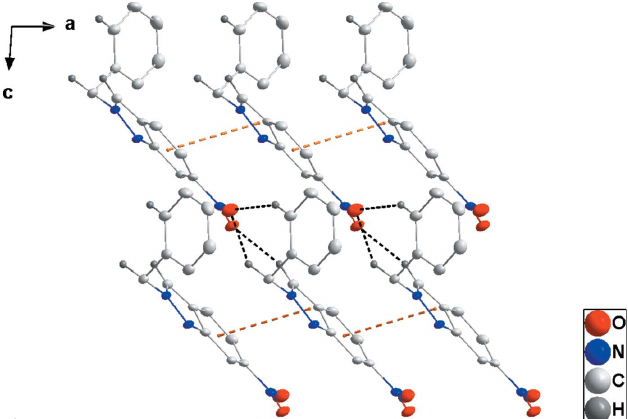
Figure 2 Detail of the intermolecular interactions, viewed along the b -axis direction. C—H (cid:3)(cid:3)(cid:3) O hydrogen bonds are shown as black dashed lines, while (cid:2) – (cid:2) stacking interactions are shown as orange dashed